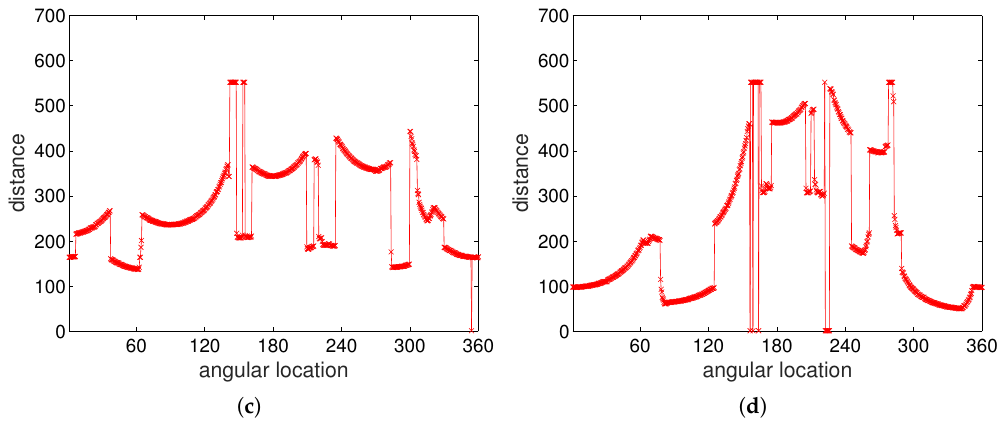
Figure 4. Omnidirectional image and distance map: ( a , b ) panoramic images at (50,50) and (62,54), respectively; ( c , d ) omnidirectional depth information at at (50,50) and (62,54),